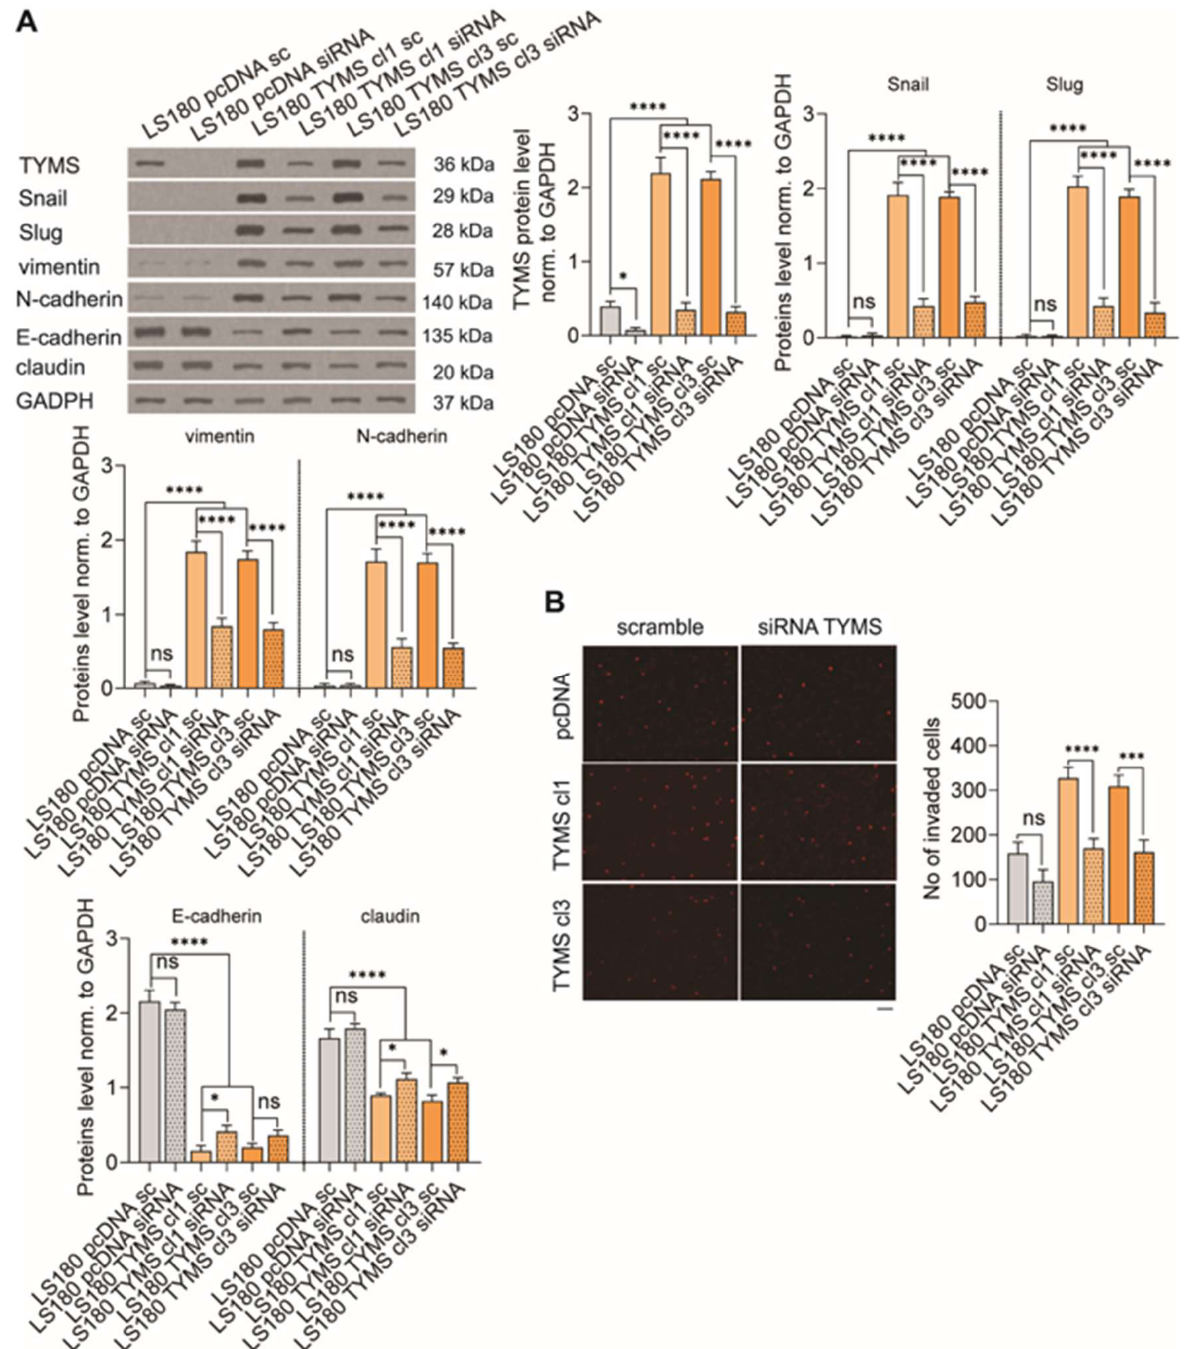
Figure 5. TYMS silencing reversed the EMT process and inhibited the invasion abilities of TYMS- overexpressing cells. TYMS was downregulated with siRNA in TYMS overexpressing cells. ( A ) The effectiveness of TYMS-silencing and EMT markers were measured by Western blot. Representative blots are shown, and graphs displaying the mean protein level normalized to GAPDH ± SD ( n = 3). ( B ) An invasion assay was performed to analyze the effects of TYMS silencing on cell invasive properties. The representative images are shown. Scale bar 100 µm.The graph displays means ± SD ( n = 3). sc—scramble; siRNA—siRNA targeting human TYMS; ns—non-significant; * p < 0.05, *** p < 0.001, **** p < 0.0001.